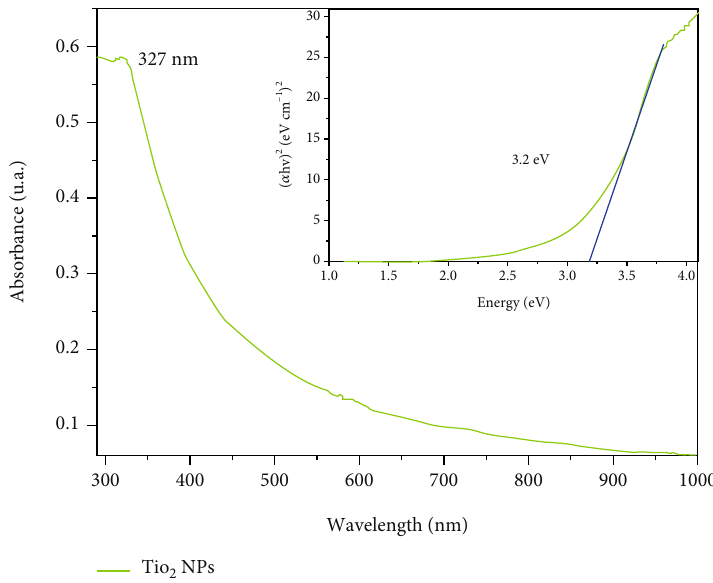
Figure 1: UV-Vis absorption spectrum and Tauc diagram (a) for the bandgap energy